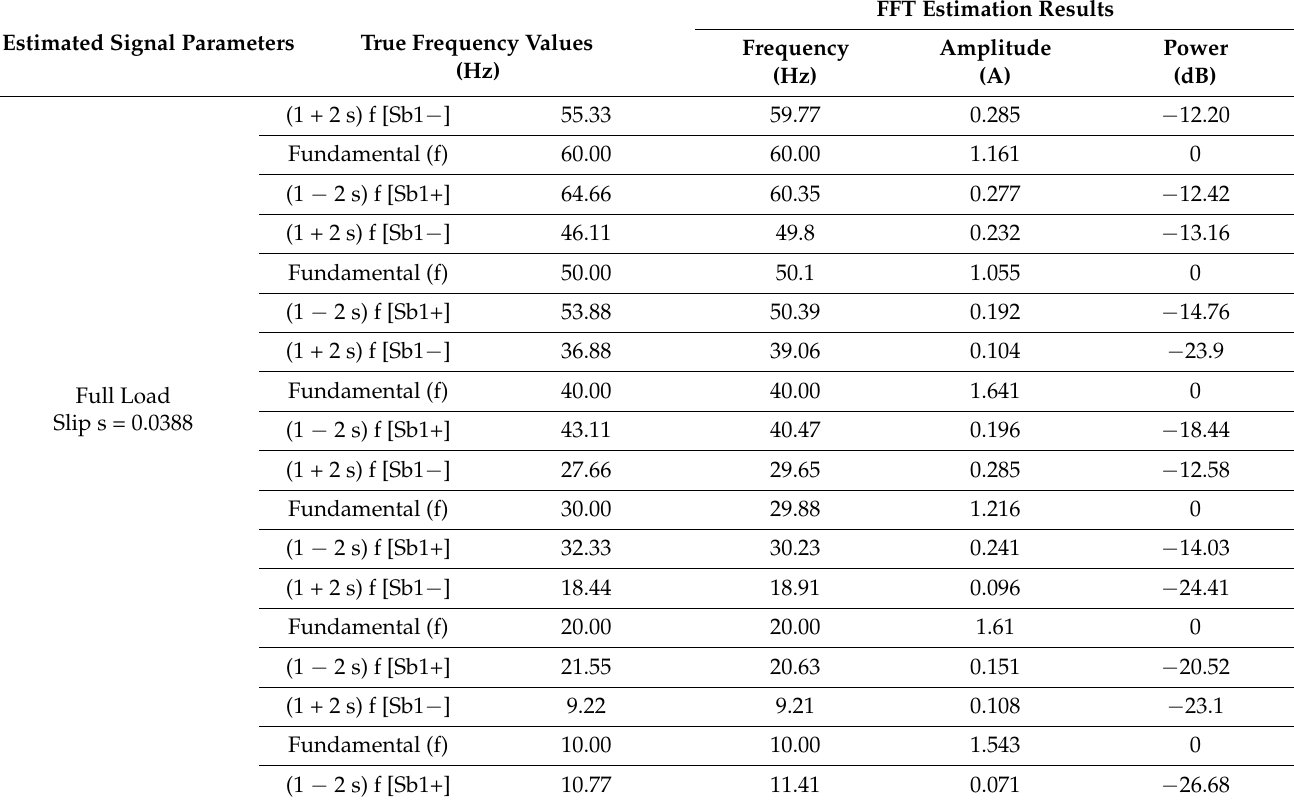
Table 5. FFT results for each speed operation condition at VFD.